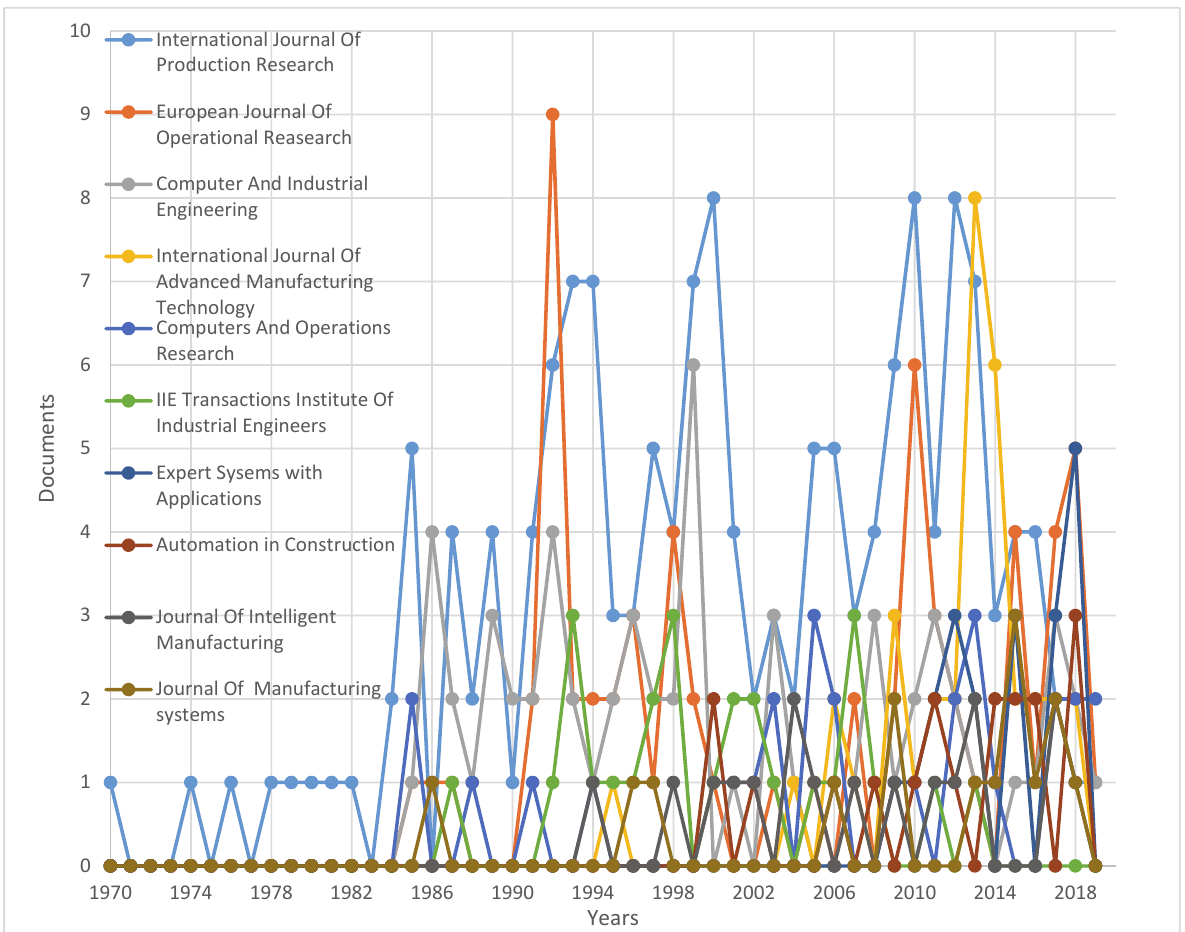
Fig.7. Documents per year by source